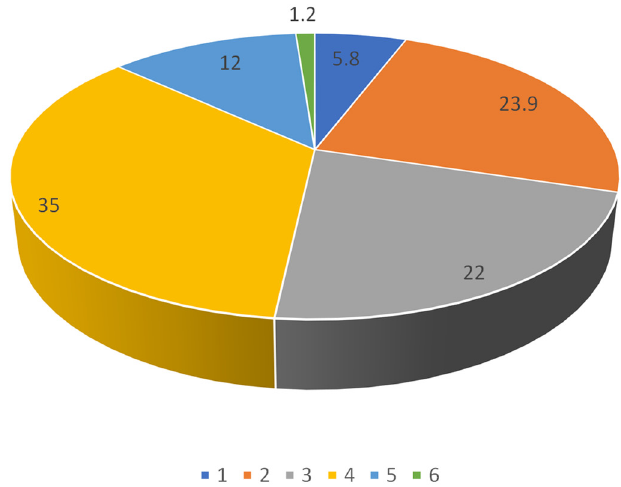
Figure 1. Schematic distribution of coal reserves according to their thickness in the context of “DTEK “Pavlohradvuhillia” PJSC mines: 1—<0.6 m; 2—0.61–0.7 m; 3—0.71–0.8 m; 4—0.81–1.0 m; 5—1.01–1.2 m; 6—>1.2 m [7,9].